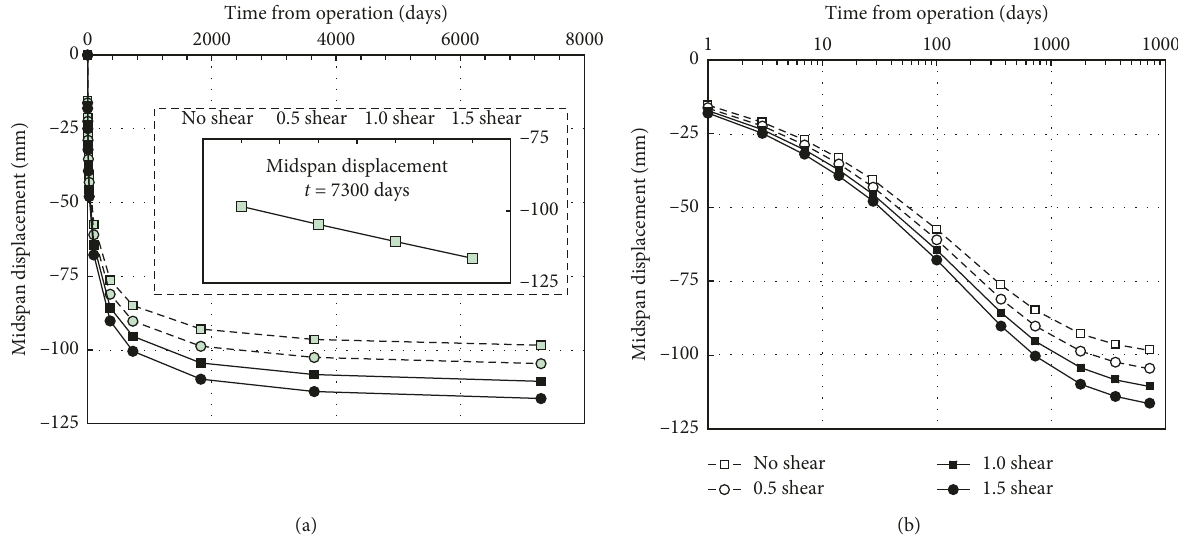
Figure 5: Deflection of midspan with different shear creep coefficients. (a) Linear coordinates. (b) Logarithmic coordinates.